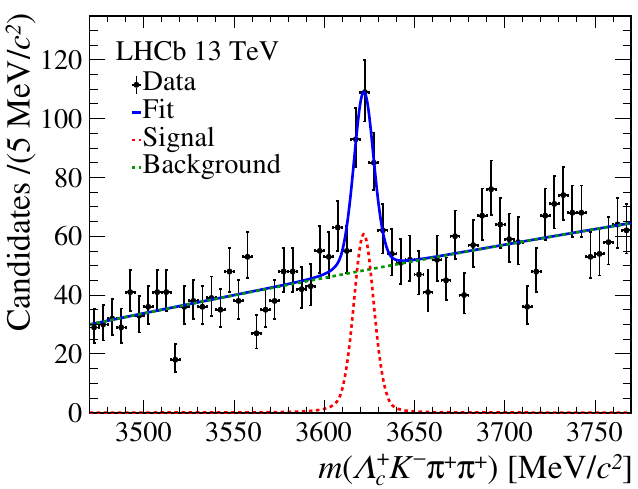
(cid:3) + K (cid:0) (cid:25) + (cid:25) + candidates with the (cid:12)t overlaid. cc ! c